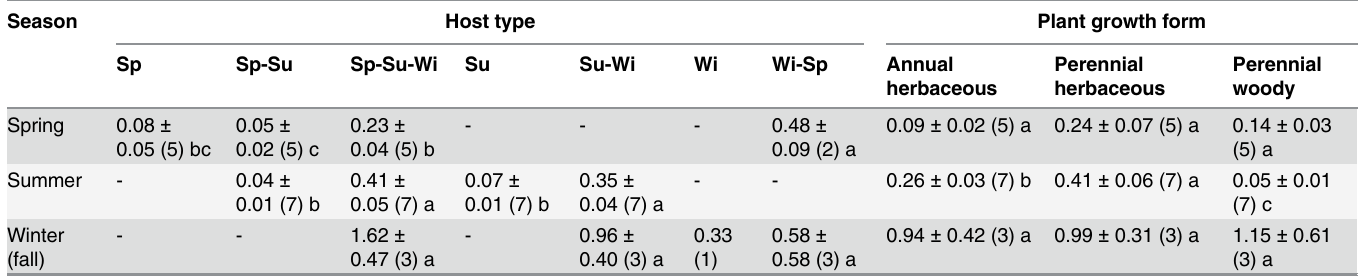
Table 5. Seasonal population densities of Apolygus lucorum on different groups of host plants during 2006 – 2012 at Langfang (Hebei Province, Northern China).